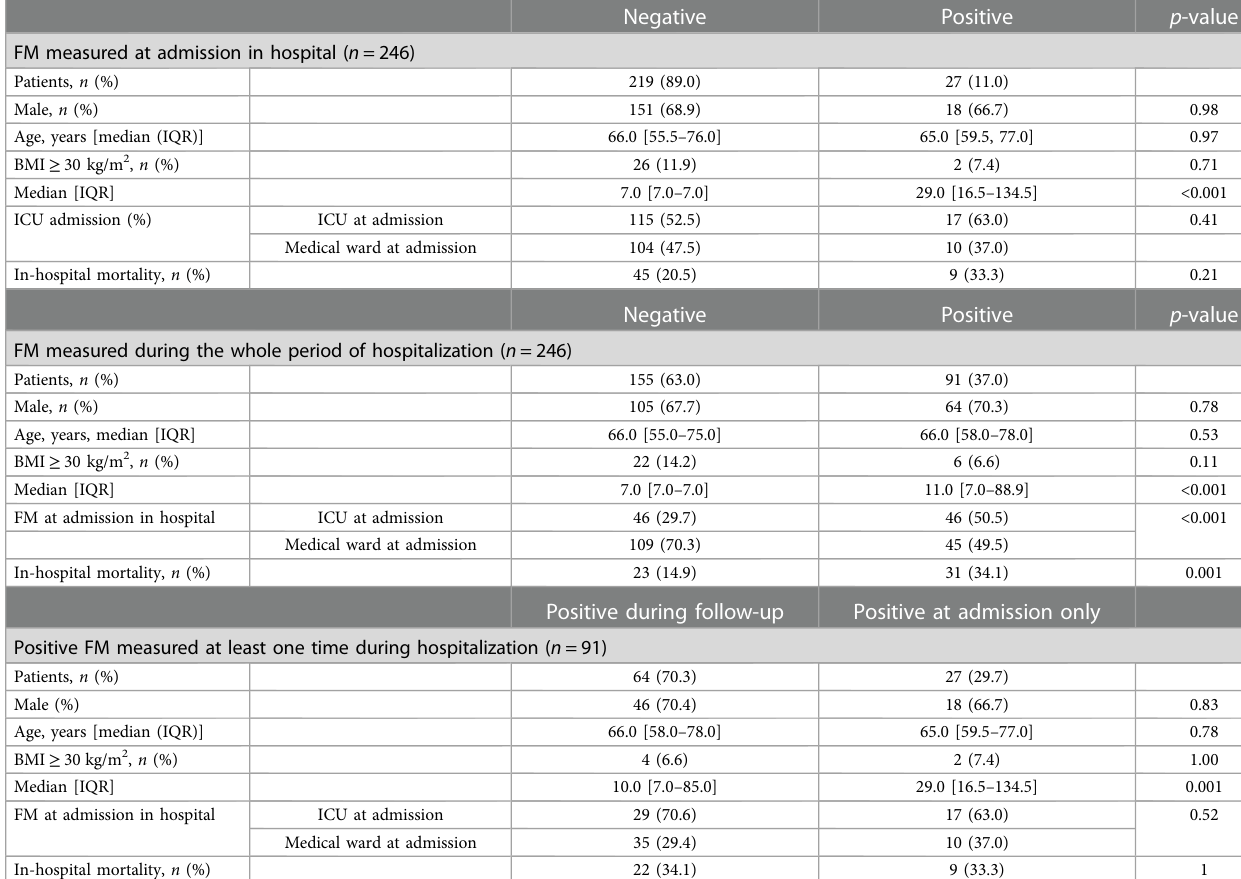
TABLE 2 Patients ’ characteristics and outcomes according to fi brin monomer measurement during hospitalization for COVID-19.